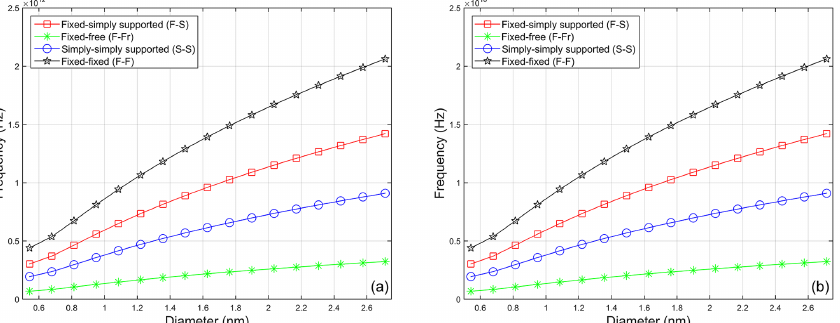
Figure 4. The first eigenfrequencies of armchair nanotubes with the nonlocal parameter µ = 0 . 1 and length (a) L = 10nm, (b) L = 100nm.